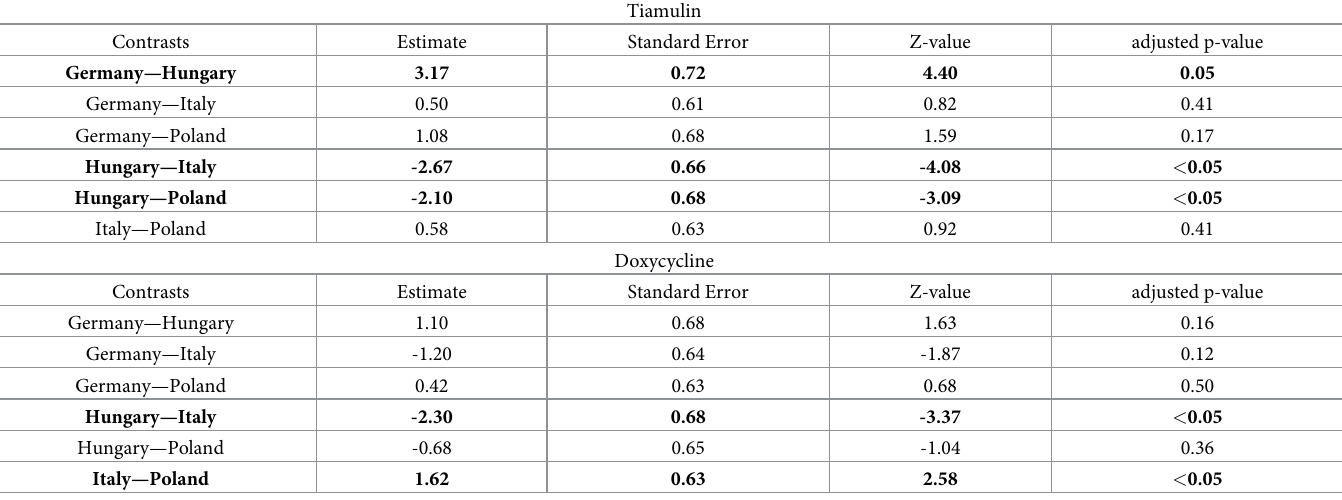
Significant differences are highlighted by bold